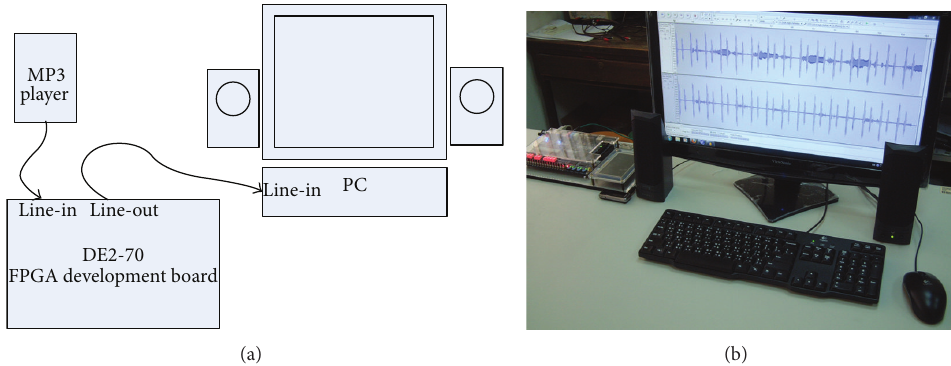
Figure 5: (a) Schematic diagram of experiment setup. (b) Photo of experiment setup.